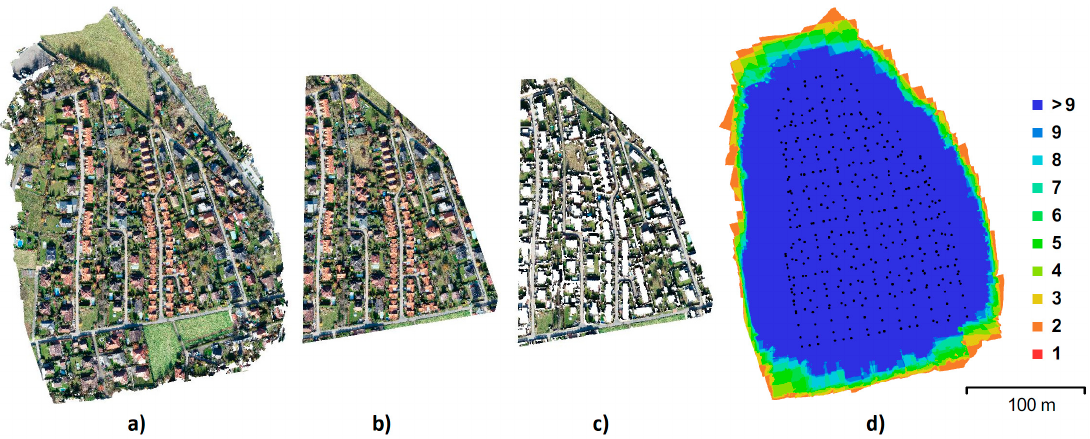
Figure 5. Urban data ( a ) original; ( b ) after cropping; ( c ) after ground filtering; ( d ) image coverage, black dots represent camera positions, and color hypsometry shows the number of overlapping frames.